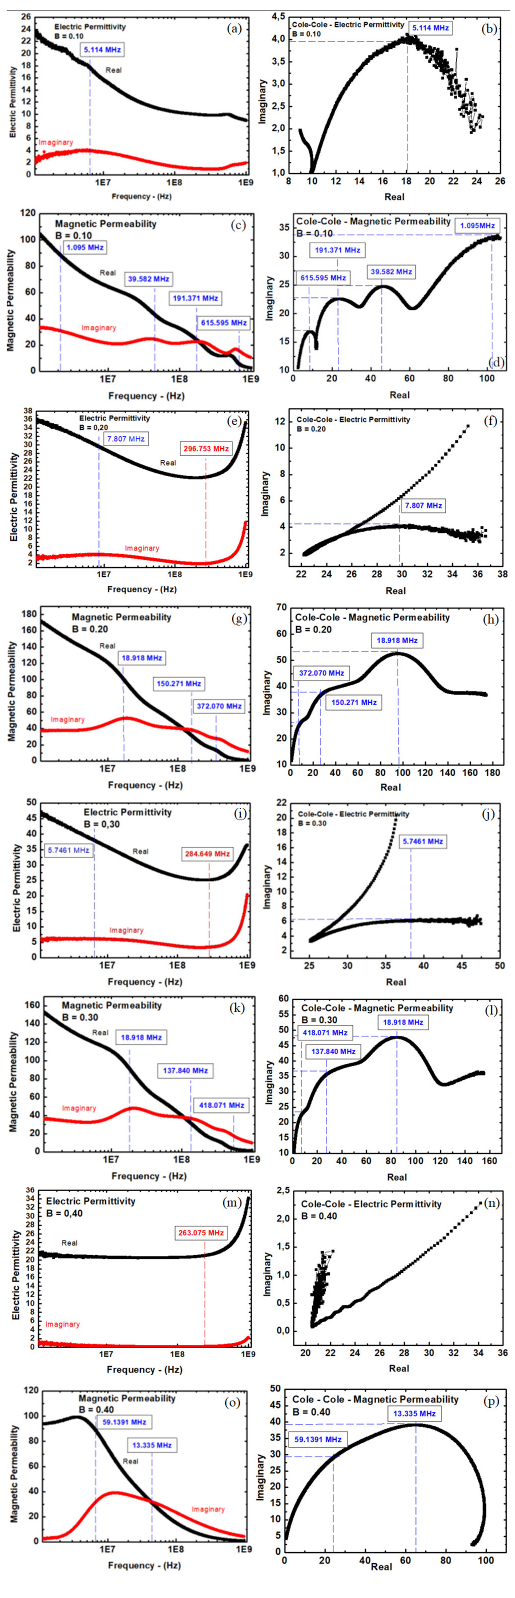
Figure 8. Complex permittivity (ε*) for β = 0.10 (a)(b), 0.20 (e)(f), 0.30 (i)(j) and 0.40 (m)(n) and complex permeability for β = 0.10 (c) (d), 0.20 (g)(h), 0.30 (k)(l) and 0.40